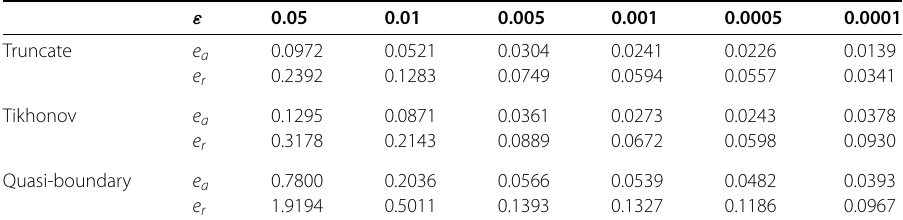
Figure 1 The comparison of numerical effects between the exact solution and its computed approximations for p = 1 with Examples 1: (a) ε = 0.001, (b) ε = 0.0001.